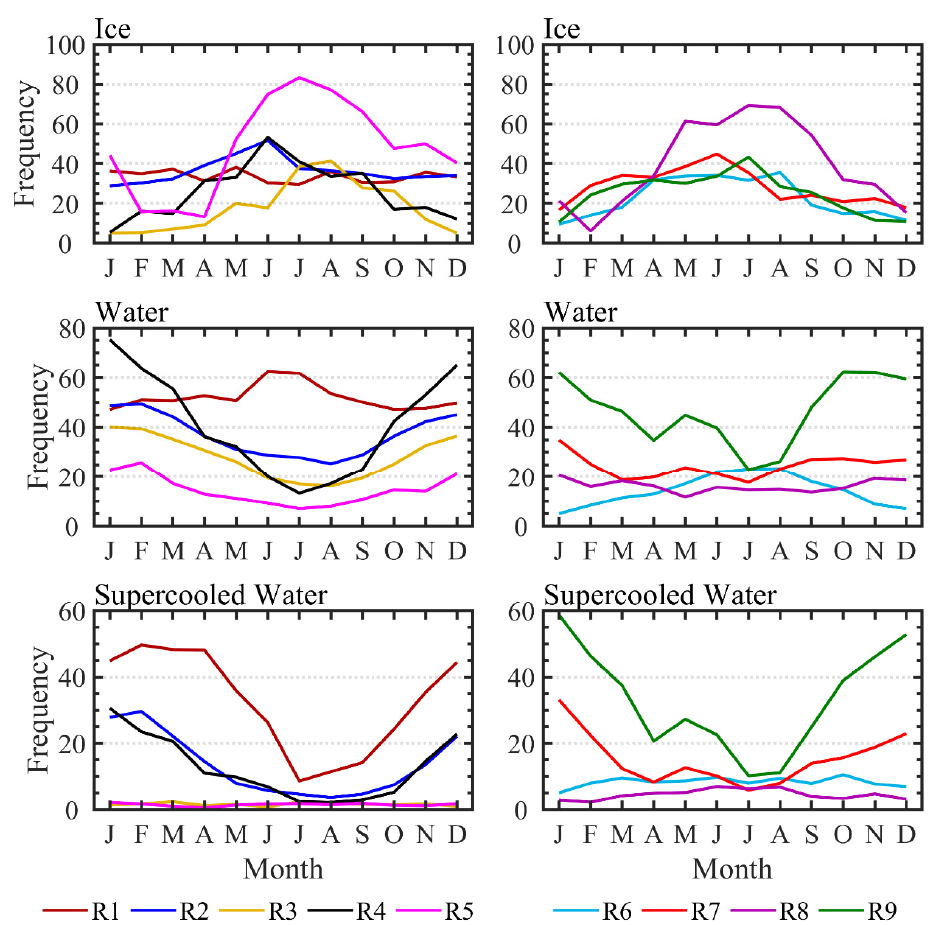
Figure 6. Monthly variations in the spatial and monthly averaged frequencies (unit: %) of different cloud-top phases over five maritime regions (left panels) and four continental regions (right panels). Figure 7 and Figure 8 further present the probabilities of cloud-top phases, divided into 5 °C CTT bins, for the boreal summer and winter, respectively. In summer, convection is active and deep. All nine regions of interest follow the trend that the lowest CTT of ice clouds decreases as the near-surface air temperature increases (Figure 7). The seasonal mean near-surface air temperature is 11.7 °C in the WNP east of Hokkaido (R1). As a re- sult, cloud tops may reach − 57 °C. By contrast, cloud tops in the tropics and sub-tropics (R3, R4, R5, R7, and R8) can reach as high as the altitude where the temperature is − 75 °C, while the near-surface air temperature is >25 °C. The highest CTT of ice clouds also changes with latitude and near-surface temperature. Ice clouds with CTTs higher than − 15 °C can be observed in R1. However, ice cloud tops with temperatures higher than − 30 °C are rare in the tropics (R3, R5, and R8). Next, we look at the supercooled water clouds. Among the nine regions, the WNP east of Hokkaido (R1) has the highest frequency of supercooled water clouds (15.0%), followed by the Sichuan Basin (R9, 14.4%). R9 also has the largest fraction (49.1%) of supercooled water clouds out of all (warm plus supercooled) water clouds (Table 2). The fractions of supercooled water clouds are lower over the five maritime regions (<30%, R1–R5) than over the four continental regions (>38%, R6–R9).